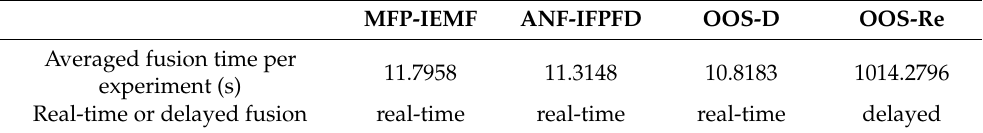
Figure 7. ANCTTs in experiment 1. Table 1. Averaged fusion time of each compared method for experiment